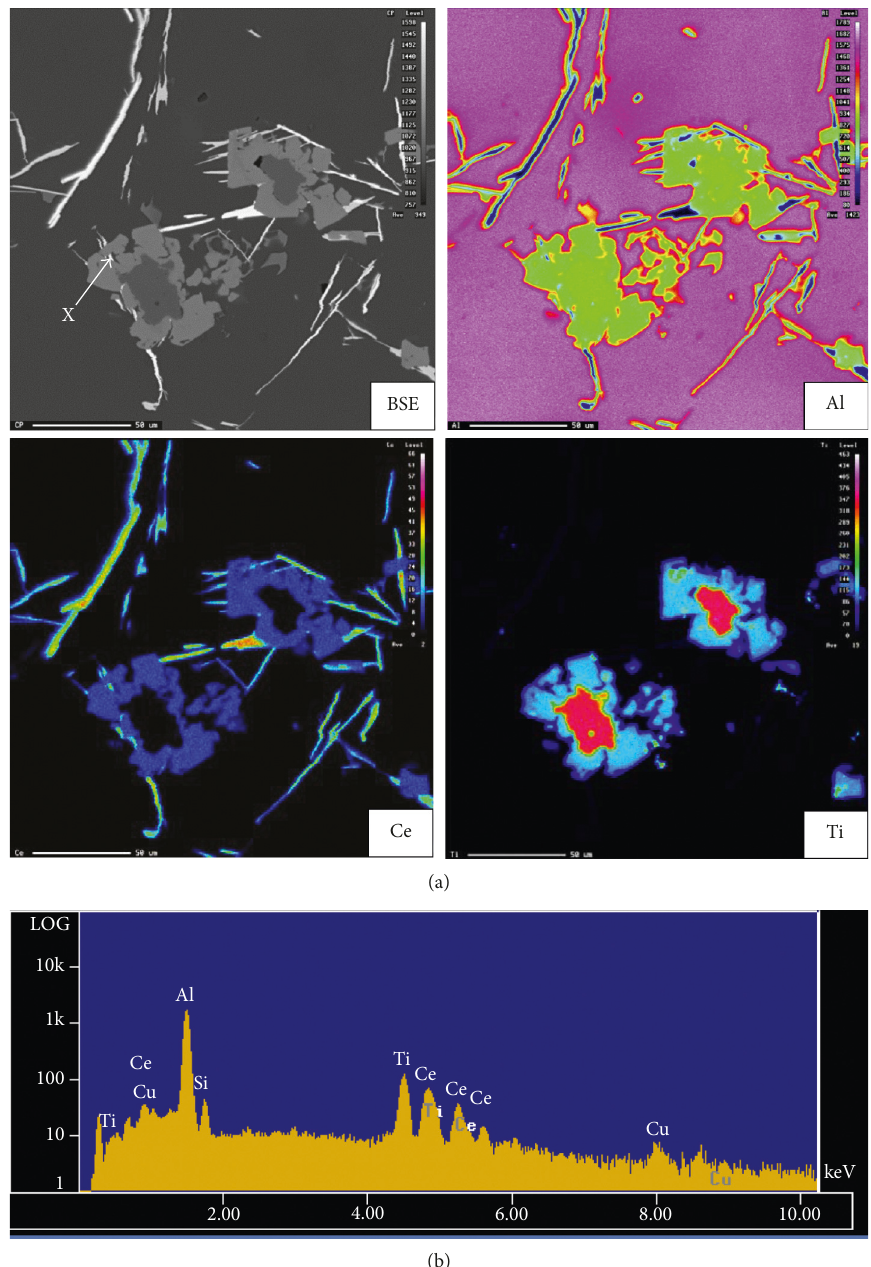
Figure 8: (a) Backscattered electron image and distribution of Al, Ce, and Ti in D0 +Ce +Ti alloy and (b) EDS spectrum corresponding to the gray phase marked X in (a). (Note the weak peak of Si compared to the Ti